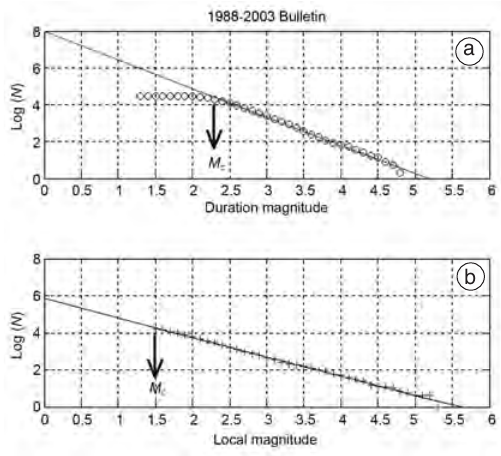
Fig. 9a,b. a) Minimum magnitude of completeness for M d in accordance with Habermann (1983). b) Mi- nimum magnitude of completeness for M L in accor- dance with Habermann (1983).